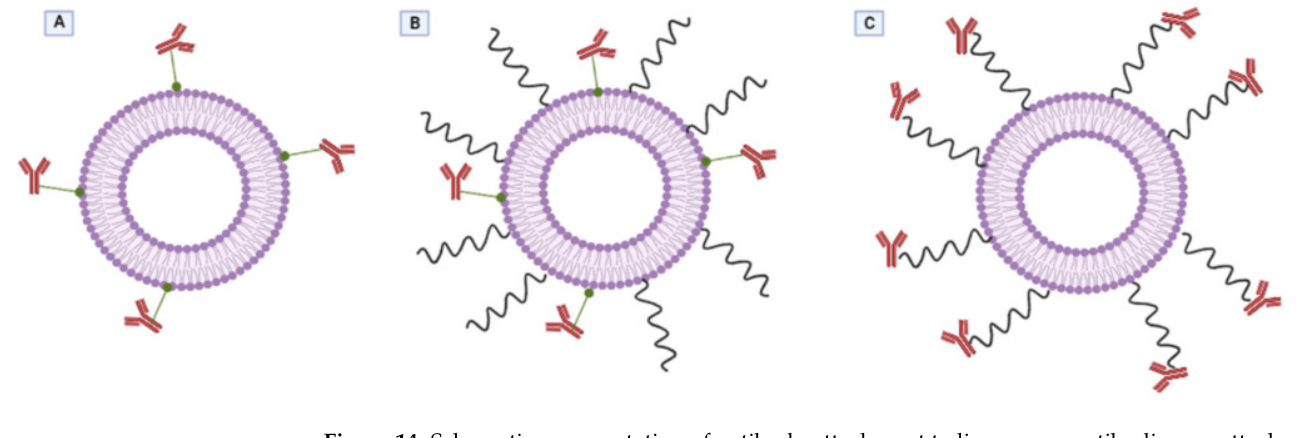
Figure 14. Schematic representation of antibody attachment to liposomes: antibodies are attached directly onto the surface of conventional liposomes ( A ), antibodies are attached directly onto the surface of PEGylated liposomes ( B ), and antibodies are attached to the end of PEG chains of liposomes ( C ). Created with BioRender.com (accessed on 10 January